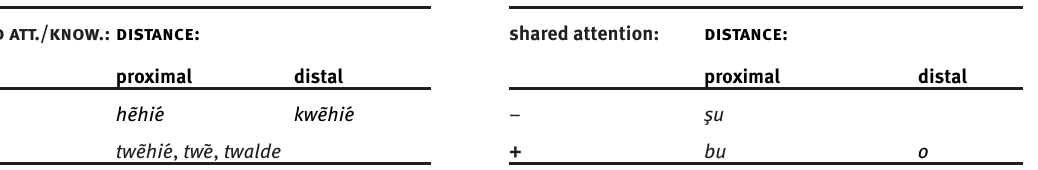
Table 8: Kogi demonstratives Table 9: Turkish